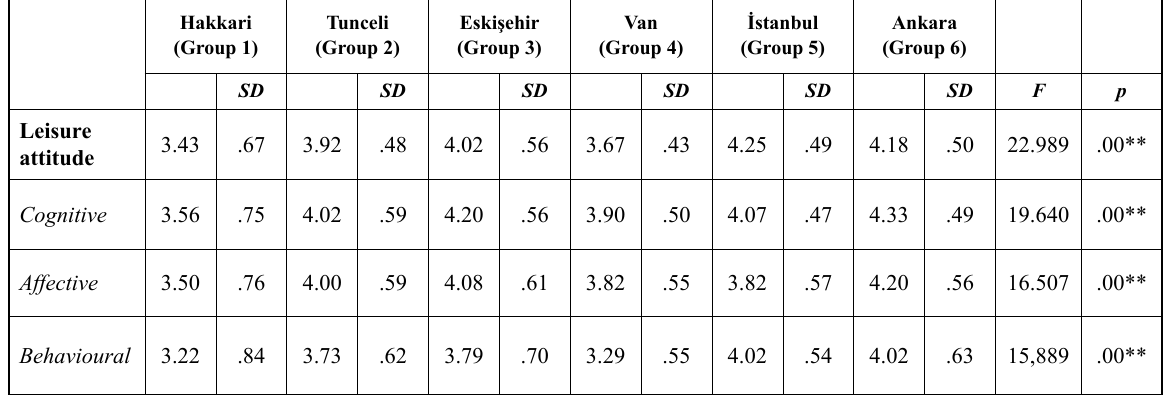
Table 6. Leisure Attitude Levels of the Participants by the Variable of the City of Residence